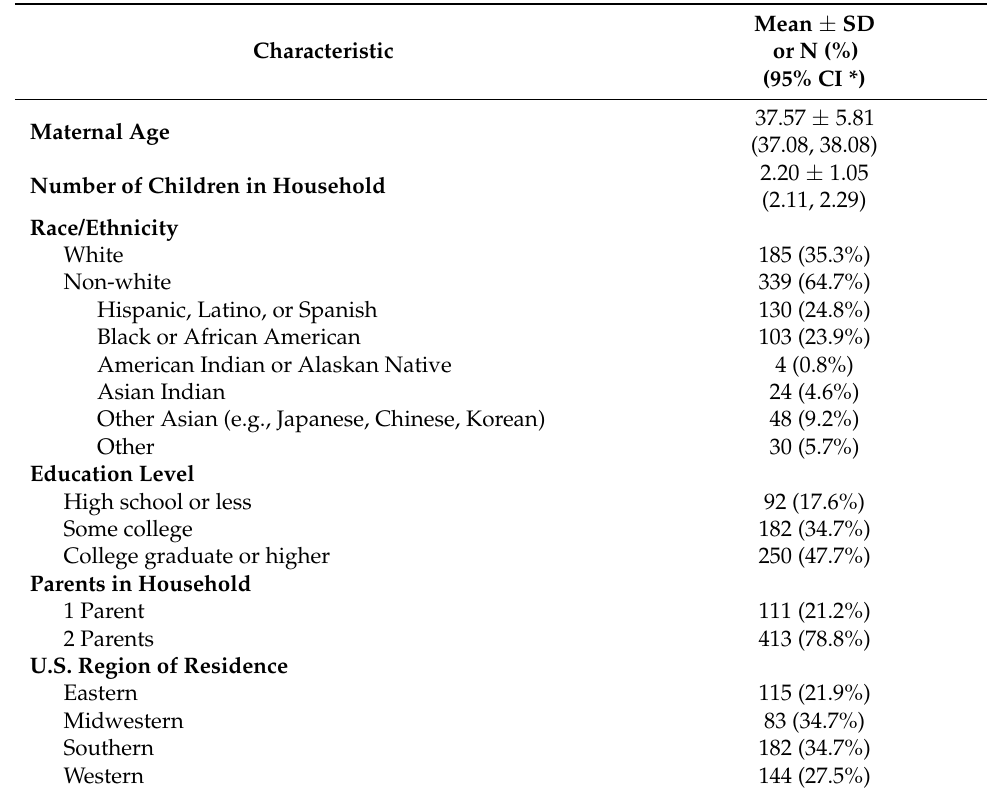
Table 2. Sociodemographic characteristics (N = 524).